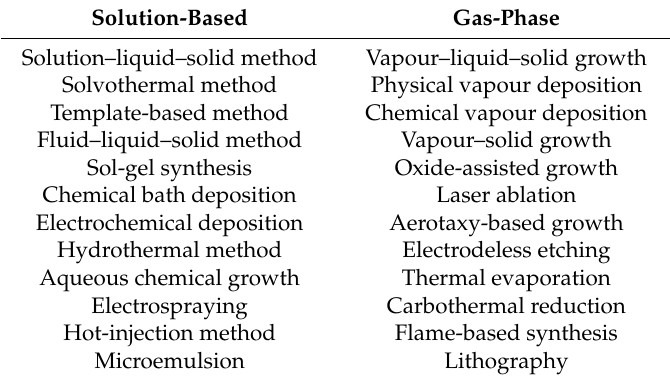
Table 6. The outline into the preparation methods of silver nanowires